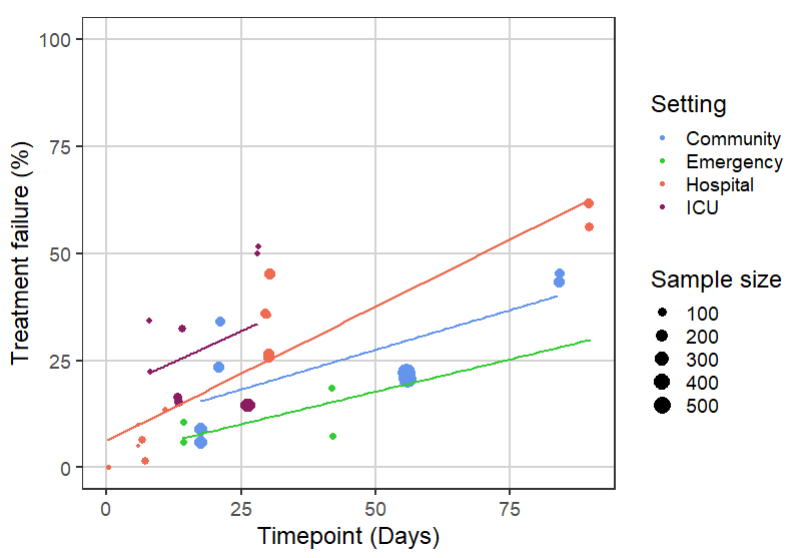
Figure 1. Treatment failure rates assessed using composite measurement instruments among par- ticipants in arms of the included trials that received treatments/interventions that are consistent with current clinical practice guidelines (i.e., study arms with experimental interventions that are not consistent with current clinical practice were excluded from this